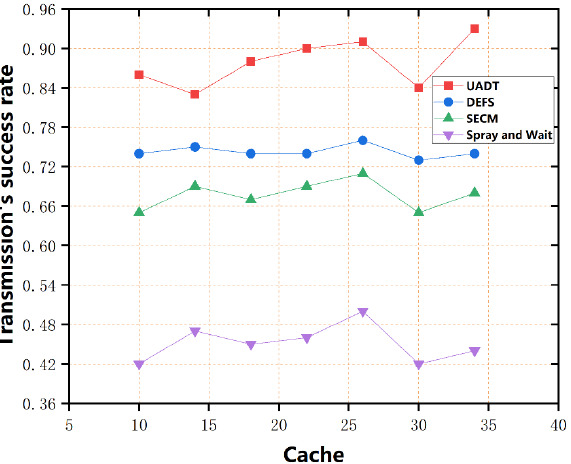
Electronics 2021 , 10 , x FOR PEER REVIEW Figure 4. Relationship between transmission success ratio and cache. Figure 4. Relationship between transmission success ratio and cache.